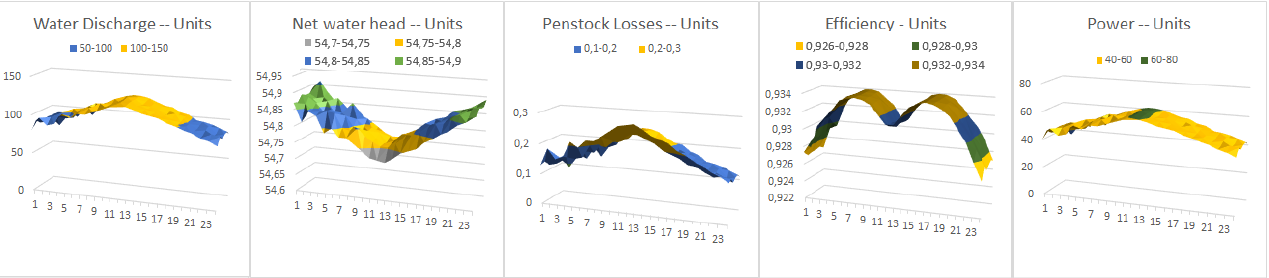
Figure 14. CRO-SL with Harmony and Gaussian Mutations substrates— CRO ( 1,4 ) . Results of Water discharge (m 3 /s). Net water head (m). Penstock (m). Efficiency (%) and Power generated (MW/h). Daily dispatch (24 h).